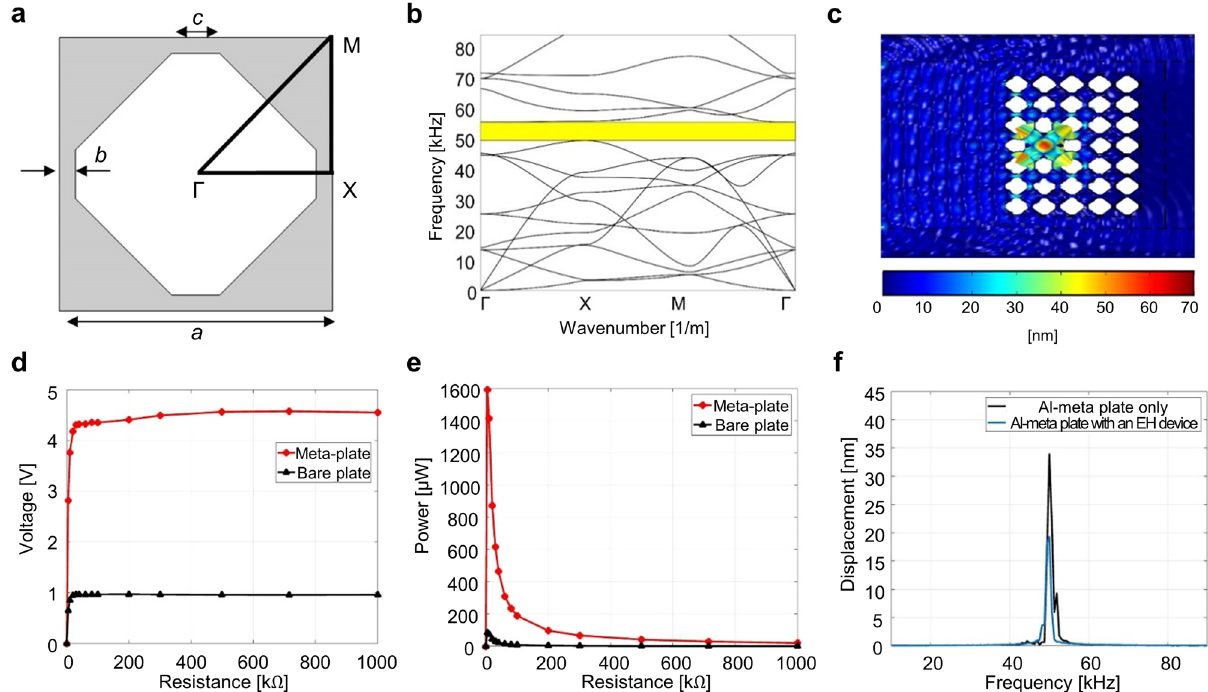
Fig. 6 Two-dimensional octagonal phononic crystals (PnCs) for energy localization and harvesting. a Unit cells of two-dimensional octagonal PnCs, a , b , and c , determine the geometric parameters. b Band structure of the unit cell calculated using the fi rst irreducible Brillouin zone ( Γ -X-M- Γ ). The yellow area represents a bandgap across which the elastic wave cannot propagate. c Simulation results of energy localization at the defect of the PnC supercell structure. d , e Output voltage and power per resistance in the metamaterial (MM) plate and the bare plate. f Displacement vs frequency obtained by fast Fourier transform (FFT) for the Al MM plate with and without an energy-harvesting device 78 . Reprinted with permission from ref. 78